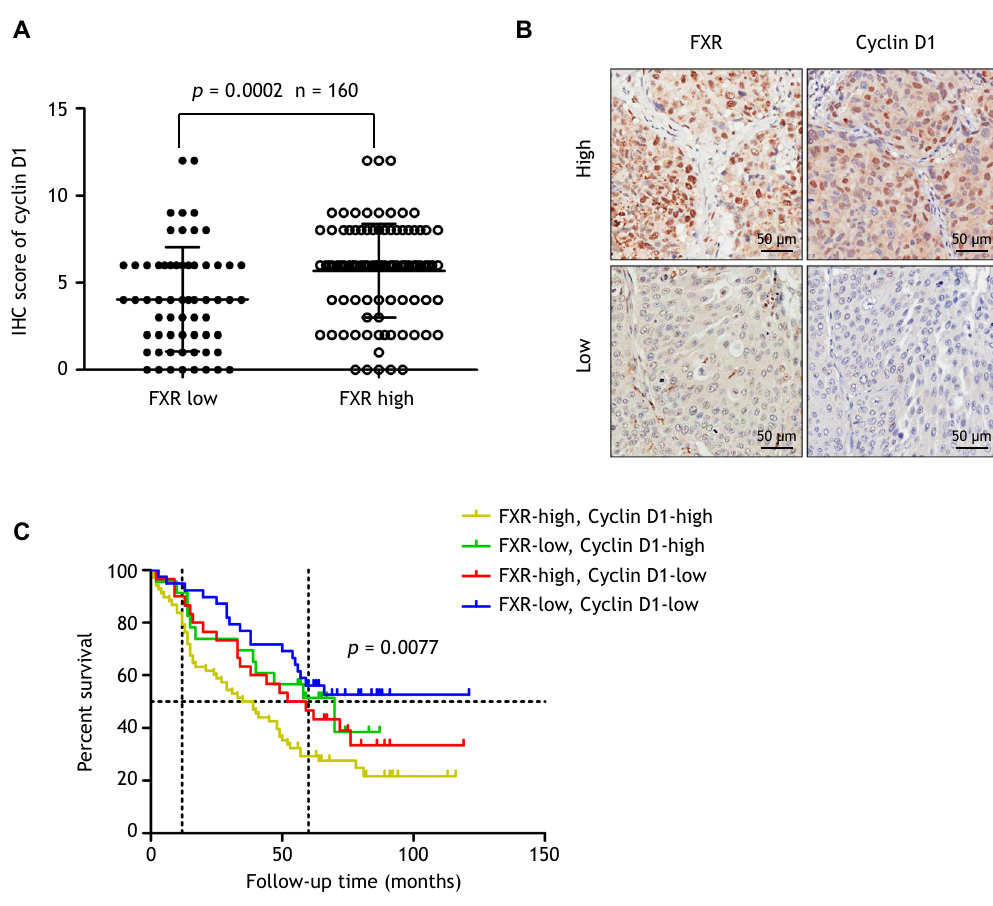
Figure 7. FXR and cyclin D1 expression are positively correlated in NSCLC samples. Cyclin D1 expression was assessed by IHC in the same cohort of specimens. ( A ) The IHC score of cyclin D1 is increased in “FXR high” tumors compared to “FXR low” tumors ( p = 0.0002). ( B ) Representative images of high (upper panel) or low (lower panel) expression of FXR and cyclin D1 in serial sections of NSCLC specimens. ( C ) Kaplan-Meier analysis showing that patients with both FXR and cyclin D1 high expression have the worst OS ( p = 0.0077).